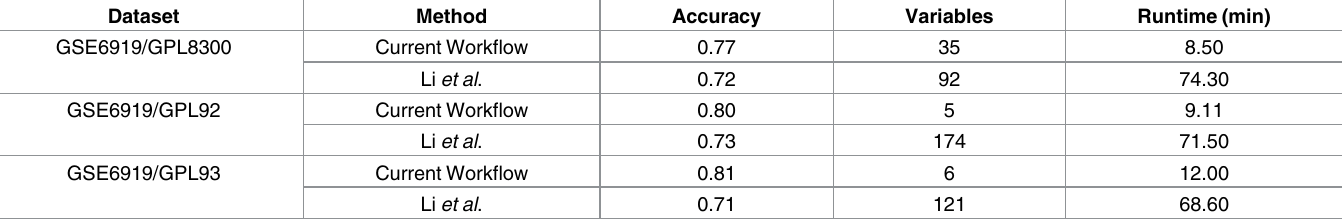
Table 3. Performancecomparison between the proposed approach (X2-PCA-RFE-RF) and the method reported by Li et al . [22]. The computer used in the originalmanuscriptwas an Intel(R) Core(TM) i5-4690 @ 3.5 GHz CPU, with 16 GB of RAM. In this study, we used an Intel(R) Core(TM) i5-4200@ 2.5 GHz CPU, with 16 GB of